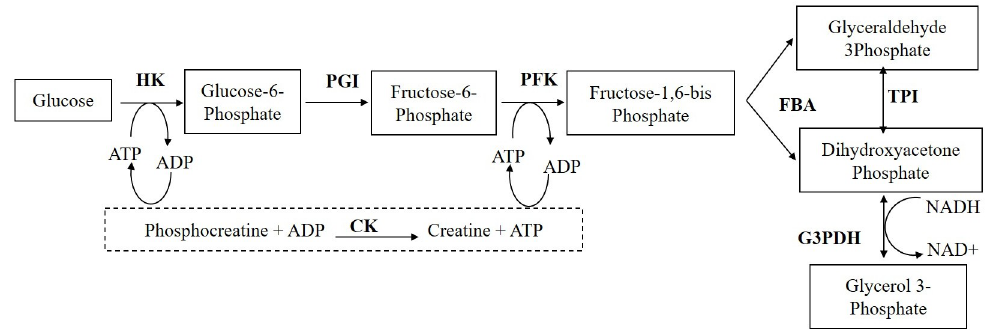
Fig 2. The upper part of glycolysis reconstructed in vitro. HK-hexokinase; PGI-phopshoglucoisomerase; PFK- phosphofructokinase; FBA-fructose bisphosphate aldolase; TPI- triose phosphate isomerase; G3PDH- glycerol-3-phosphate dehydrogenase, CK- Creatine